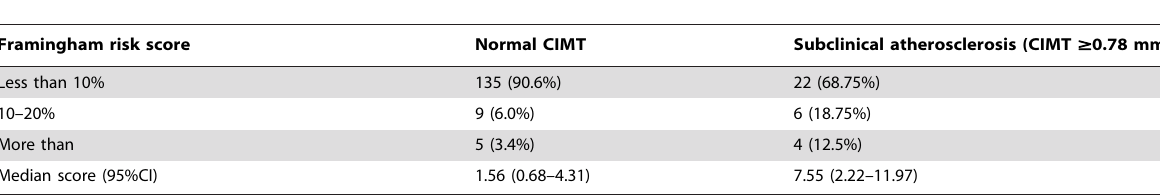
Table 3. The distribution of subclinical atherosclerosis across the Framingham risk score categories (n= 181).